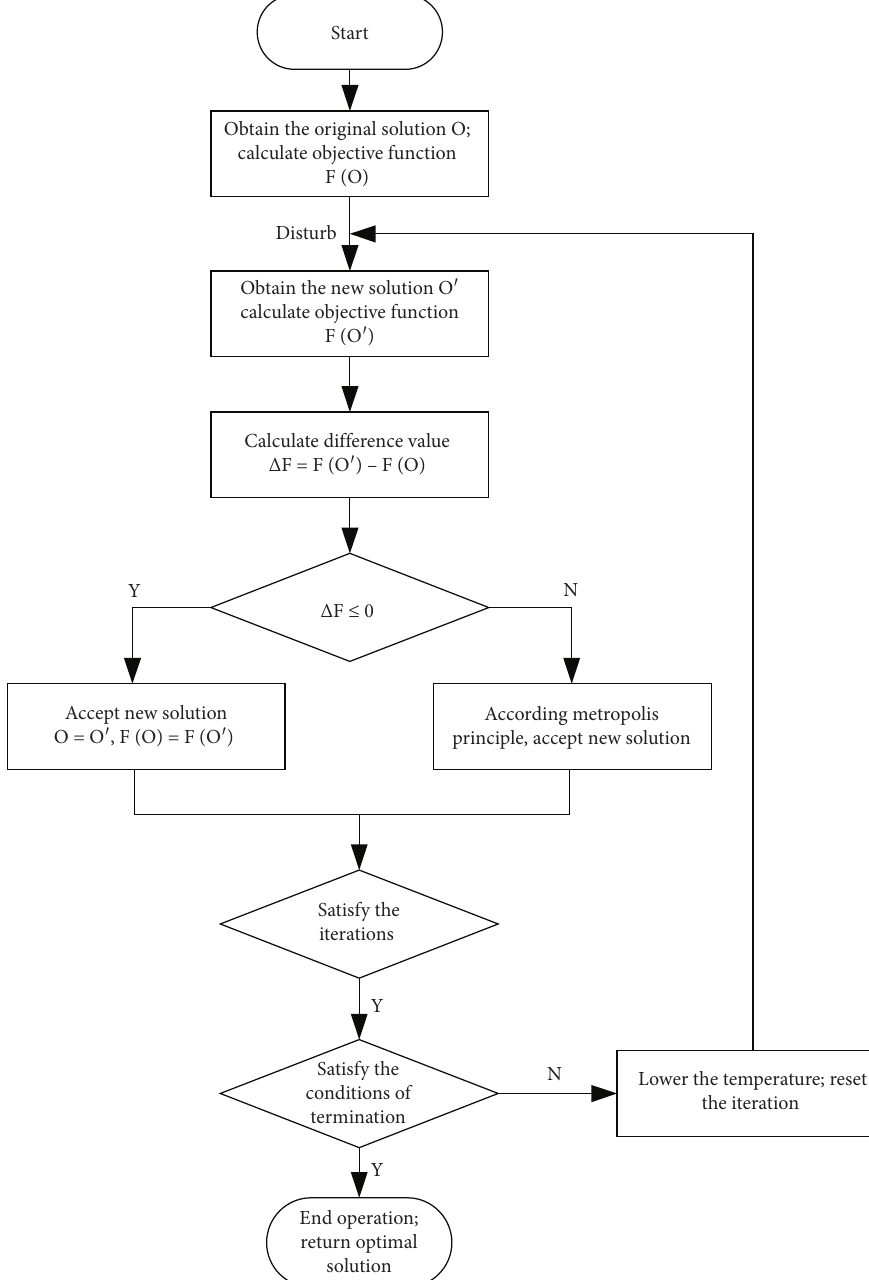
Figure 8: Flow diagram of simulated annealing (SA)